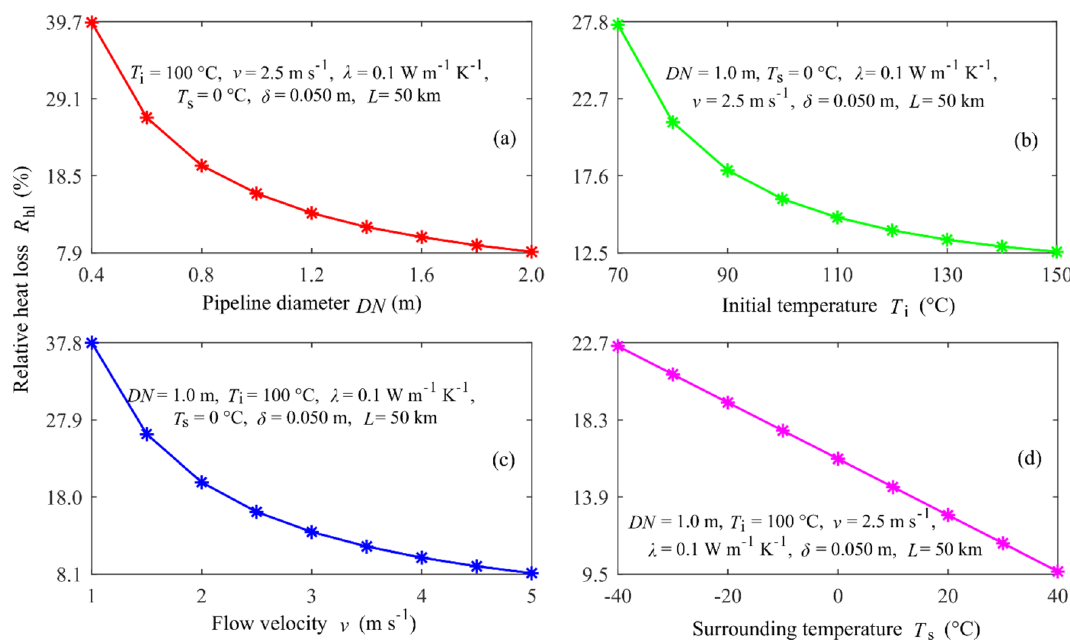
Fig. 4 Relative heat loss across the